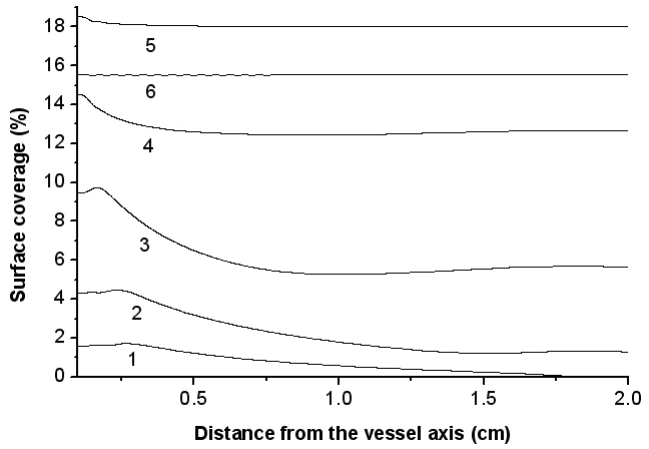
Figure 12. Numerical results on the radial distribution of the surface concentration by dissolution of a hexanol droplet under the air/water surface: 1 – t=26 min 11 s, 2 – t=26 min 12 s, 3 – t=26 min 13 s, 4 – t=26 min 14 s, 5 – t=26 min 20 s, 6 – t=27 min (for the oscillatory regime shown in Fig.